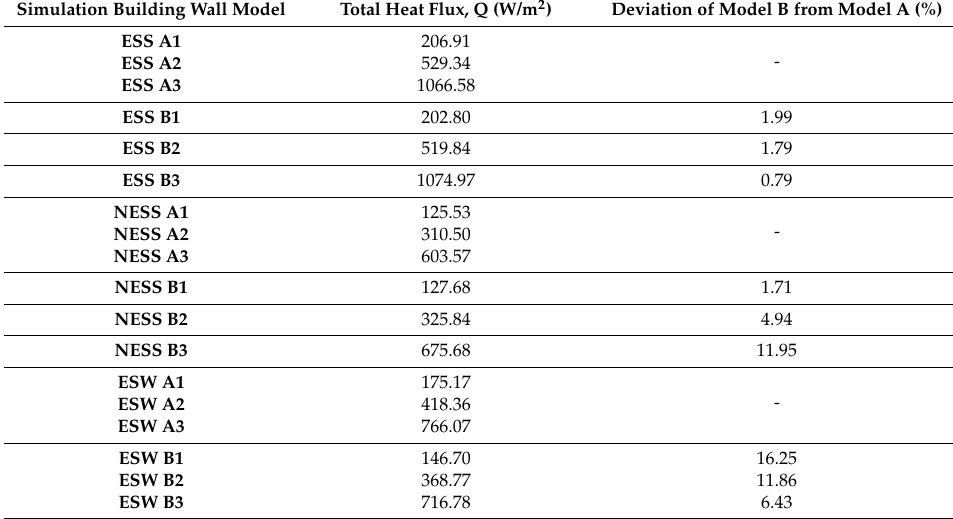
Table 3. Total heat flux of the building wall models under investigation and deviations.